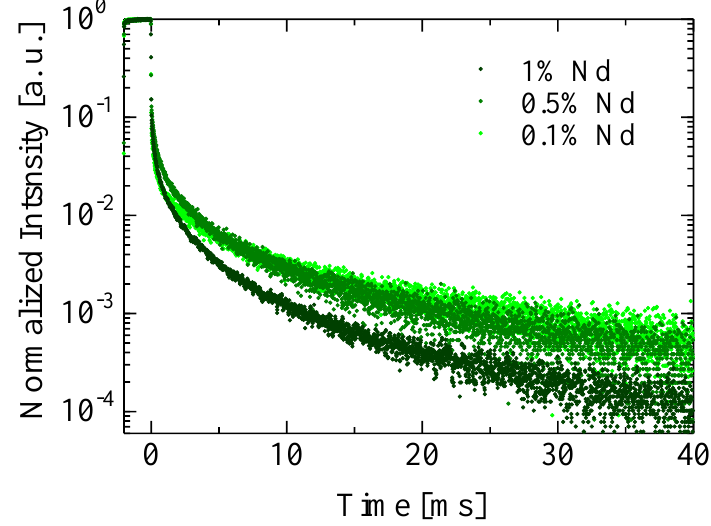
Figure 8. Afterglow curves of Nd-doped CaWO 4 .